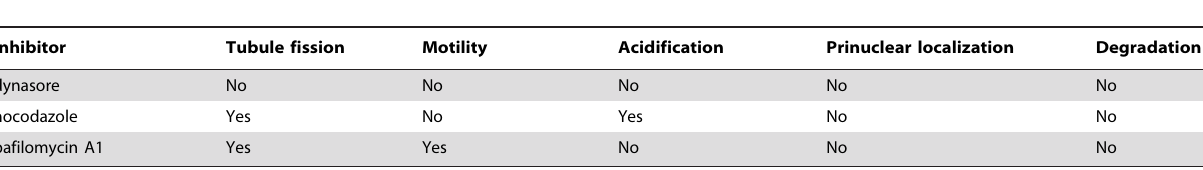
Table 1. Effects of drugs on degradative